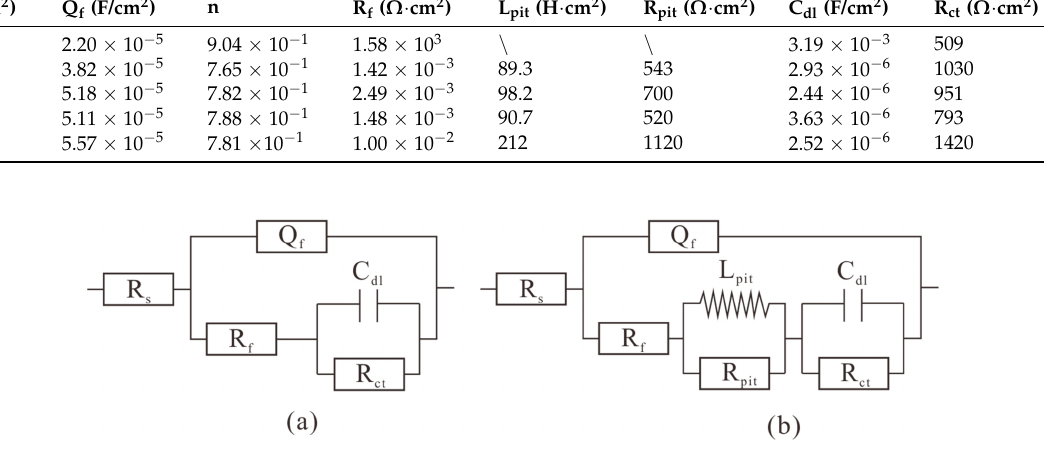
Figure 9. Equivalent circuit used to fit the EIS data in Figure 8. ( a ) d1; ( b ) d3 − d14. Table 2. Fitted electrochemical parameters for AZ31B magnesium alloy after immersion in biotic mudflat.